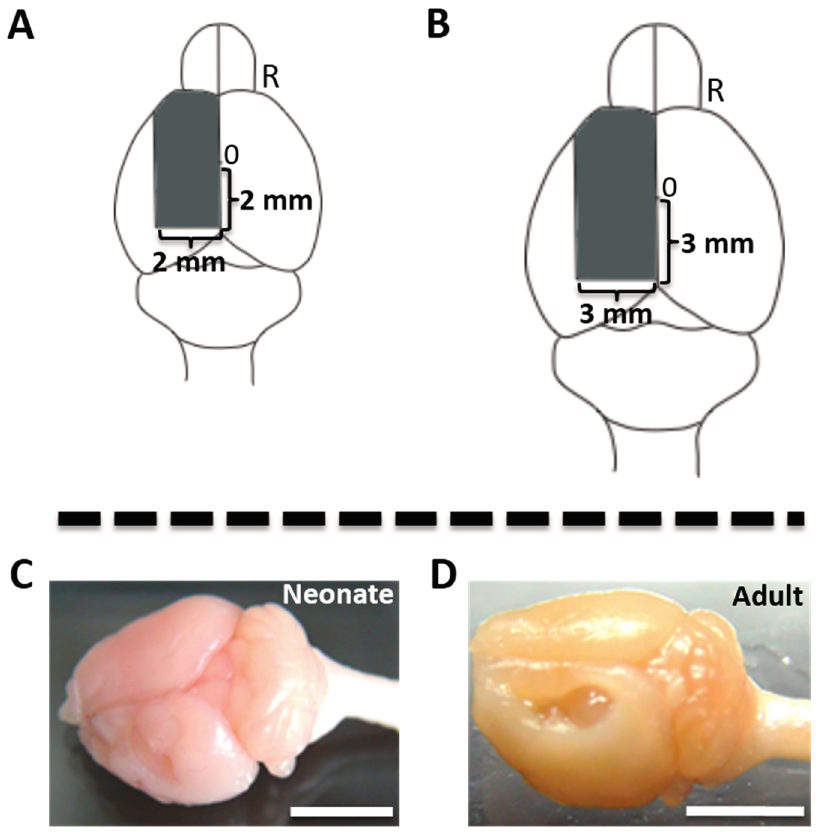
L = left side; cc = corpus callosum; LV = Lateral ventricle; CP = caudoputamen; aca = anterior commissure; CA3 = CA3 field, hippocampus; 3V = 3rd ventricle; D3V = dorsal 3rd ventricle; Scale bar = 5 mm ( C , D ) and 500 µm ( E – J